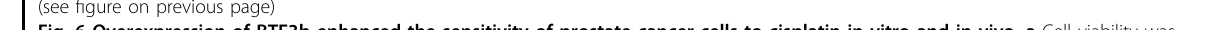
cisplatin sensitivity through transcriptional regulation of other RFC components or multiple RFC subunits.